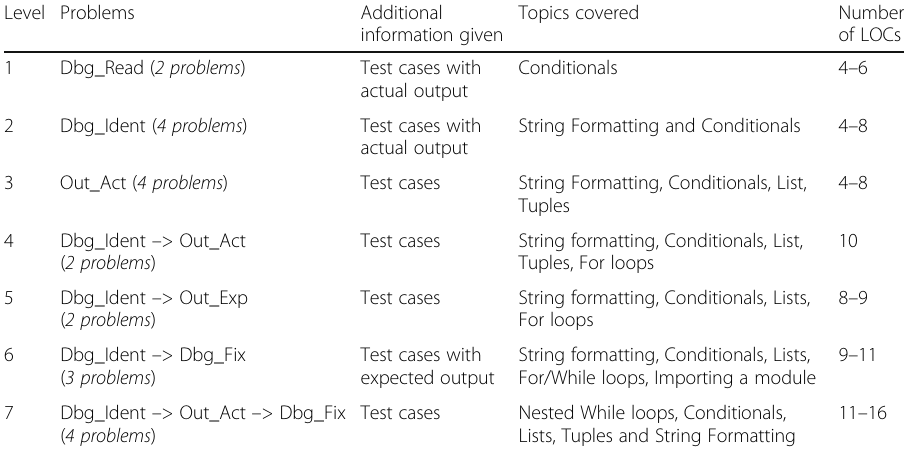
Table 2 Combinations of activities in levels 1 –